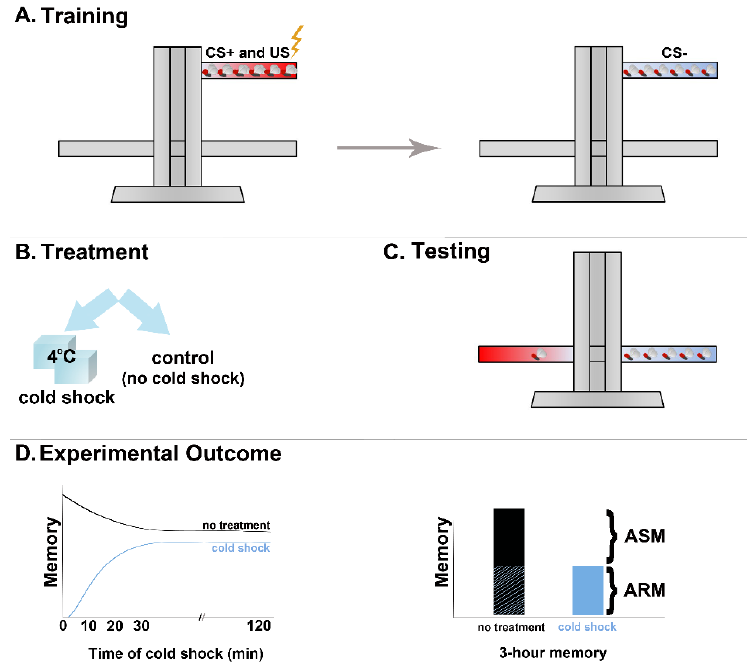
Figure 1. Aversive olfactory association paradigm in Drosophila. ( A ) Training of flies consists of pairing an odor (CS+) with electric foot shock (US) followed by presentation of another odor (CS-) in the absence of shock. ( B ) Treatments, such as cold shock, may be employed after training. ( C ) Testing of the performance for the previously learned association involves simultaneous presentation of the CS+ and CS- odors for the flies to choose. ( D ) Calculation of the performance index results in a representation of memory retention. In the case of cold shock treatment two hours post training, MTM loses its ASM counterpart and consists only of ARM.